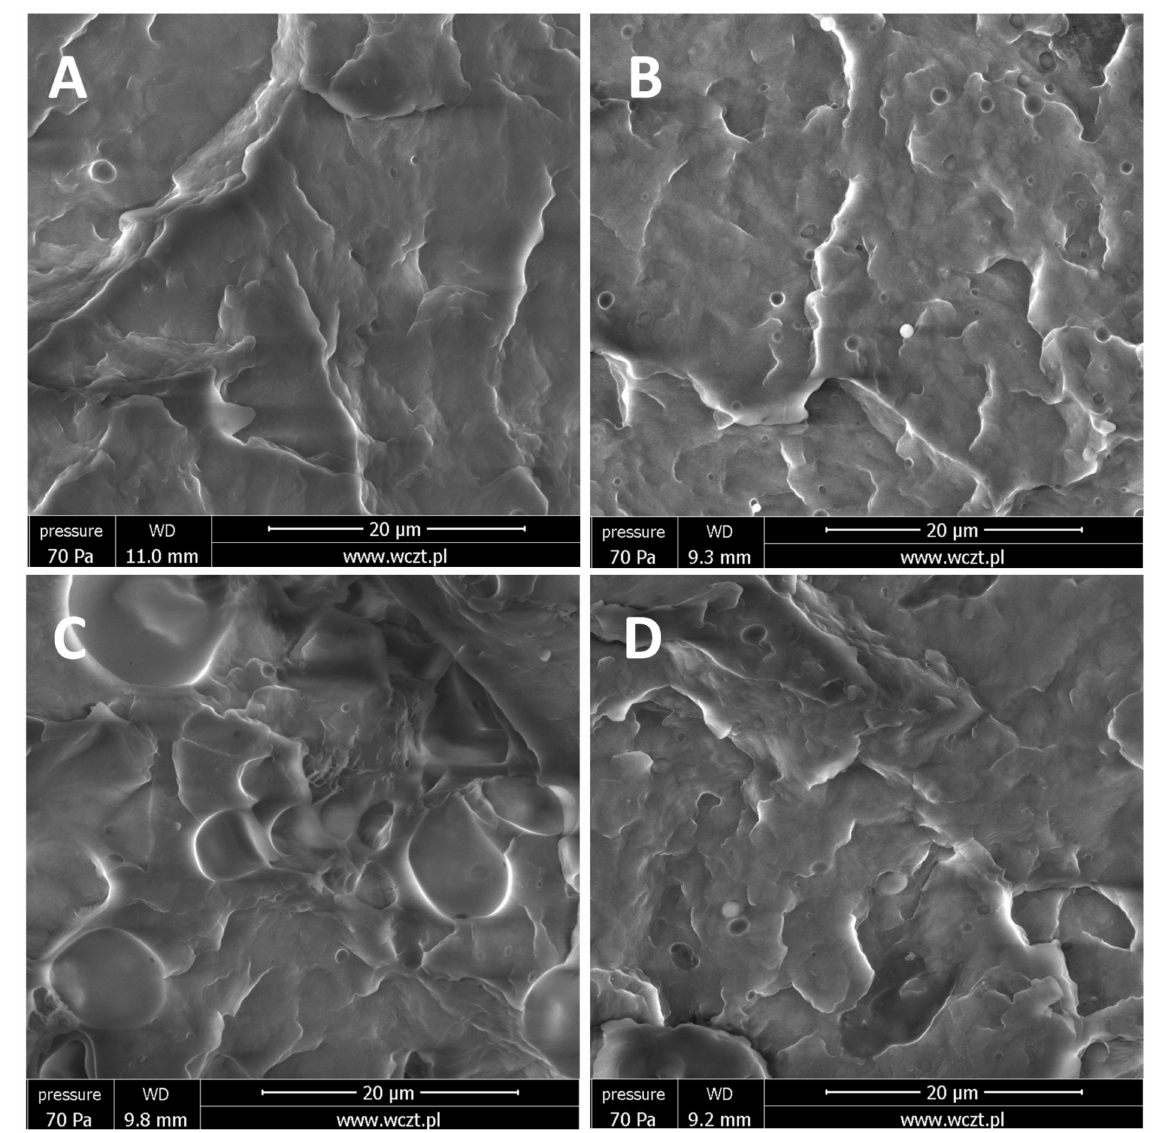
Figure 5. SEM images SS-Glycidyl/iPP composites. ( A )—0.1%, ( B )—0.25%, ( C )—0.5%, ( D